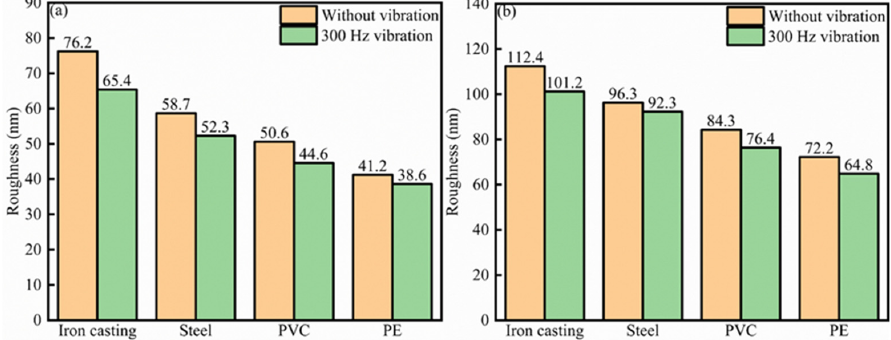
Figure 11. The roughness of iron casting, steel, PVC and PE in ( a ) clean water; ( b ) sewage